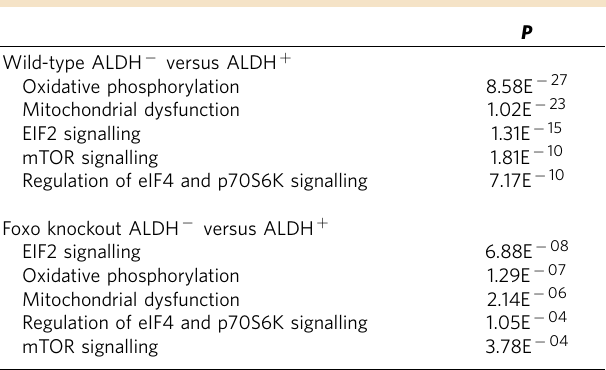
The table summarizes top pathways from transcriptome analysis of ALDH (cid:3) versus ALDH þ cells.